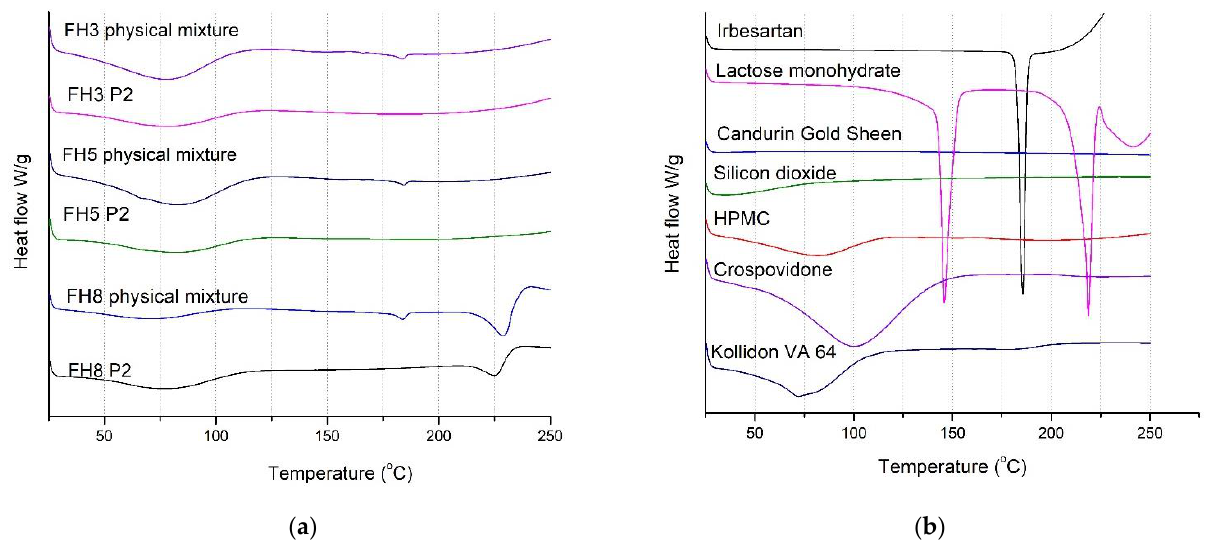
Figure 8. DSC curves of ( a ) selected physical mixtures and SLS irbesartan tablets, and ( b ) irbesartan and excipients.